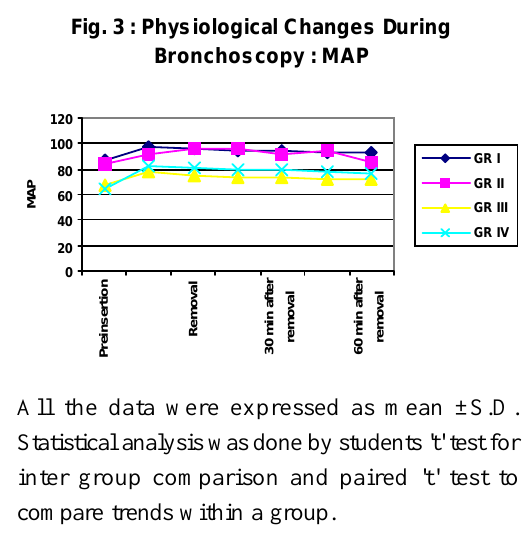
Fig. 1 : Physiological Changes during